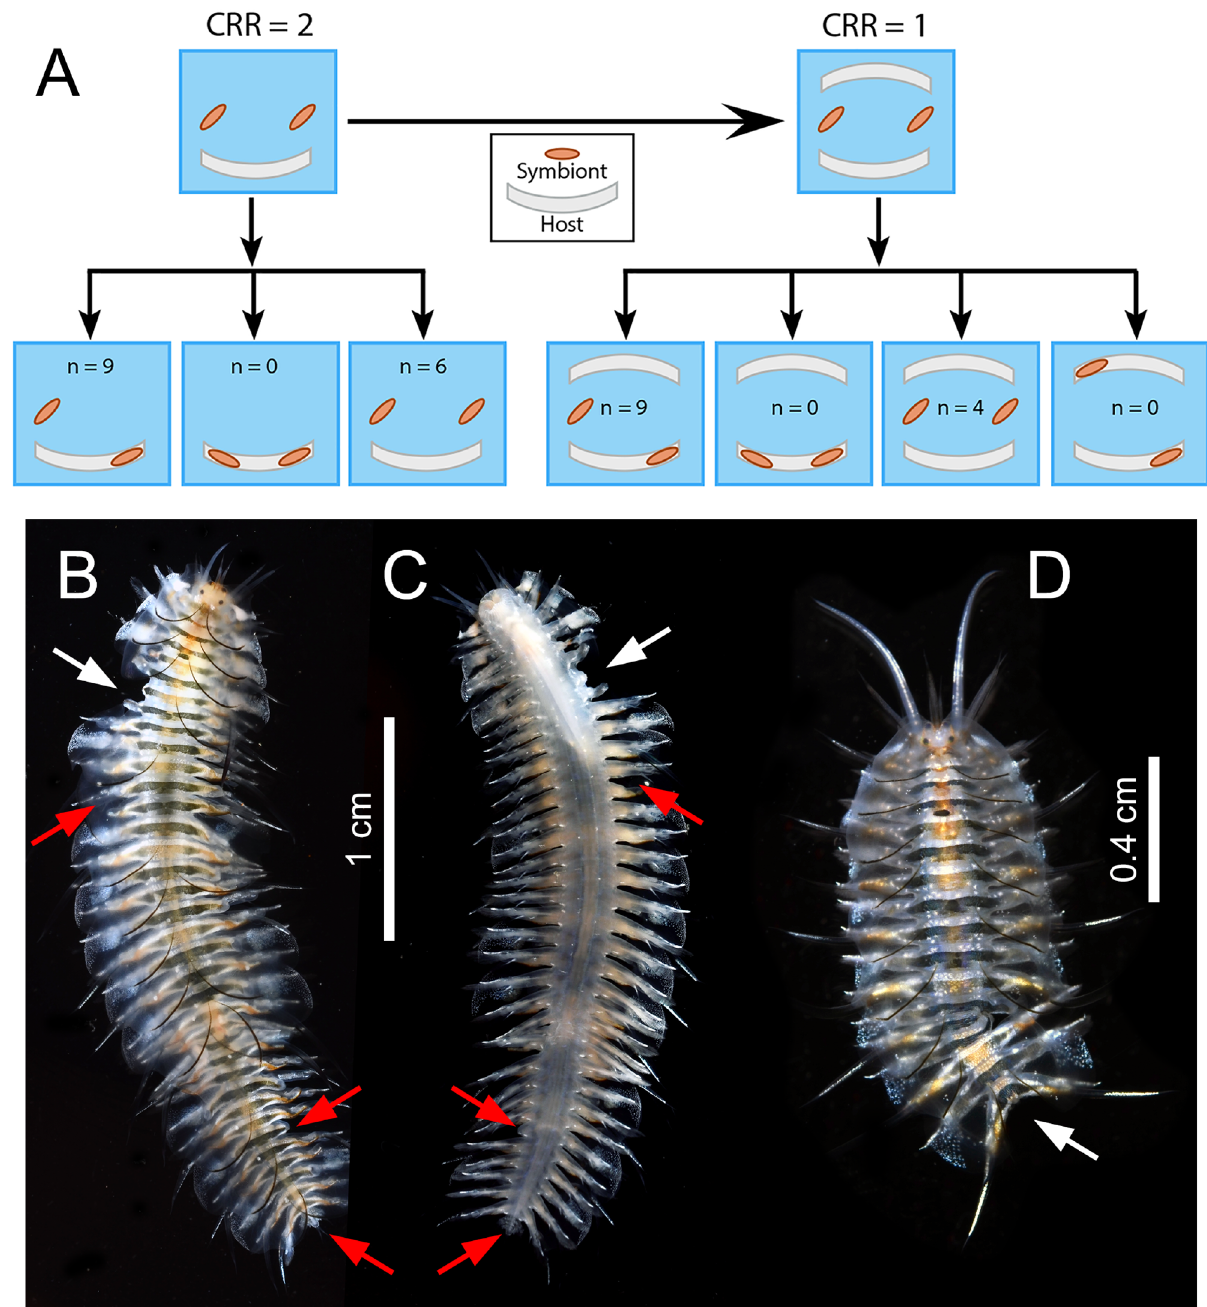
Figure 7. ( A ) Scheme of the treatment design in the manipulating competitor-to-resource ratio (CRR) experiment, showing the outcome of the two treatments. Dorsal ( B ) and ventral ( C ) views of an intruder Ophthalmonoe pettiboneae showing both recent (four left parapodia, two elytra) and old, regenerating (two left and one right parapodia, several posterior segments) injuries. ( D ) Ophthalmonoe pettiboneae with a posterior injury affecting ca. two body thirds; white arrow: recent injury; red arrow: old, regenerating and one outside (Fisher exact test, p = 0.05). In six replicates (40%) both symbionts were outside the host (Fisher exact test, p = 0.05). Cases of two symbionts sharing the same host were never recorded (Fig. 7A). During all replicates, we observed: (1) one symbiont chasing the other, twice outside and once inside the tube, (2) one independent attack inside the tube that occurred during daytime, and (3) two successive attacks outside the tube that occurred during nighttime. In the CRR = 1 treatment, the number of hosts harboring a single symbiont versus no symbiont versus two symbionts also differed significantly from each other (critical Chi-square = 9.4, p < 0.001). The case with one sym- biont inside the host and one outside was significantly more common (Fisher exact test, p = 0.05), although the prevalence was substantially reduced with respect to the CRR = 2 treatment (i.e., only nine hosts—35%—harbored